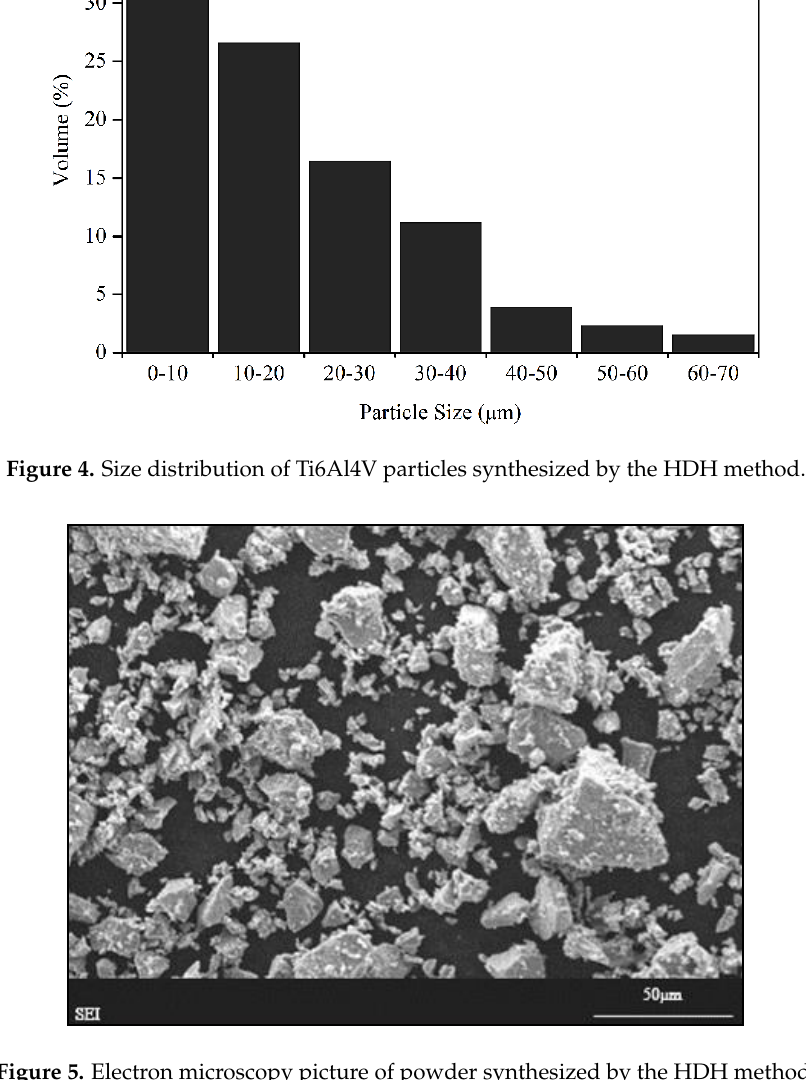
Figure 5. Electron microscopy picture of powder synthesized by the HDH method. Table 1. Elemental analysis of dehydrogenated powder and relevant